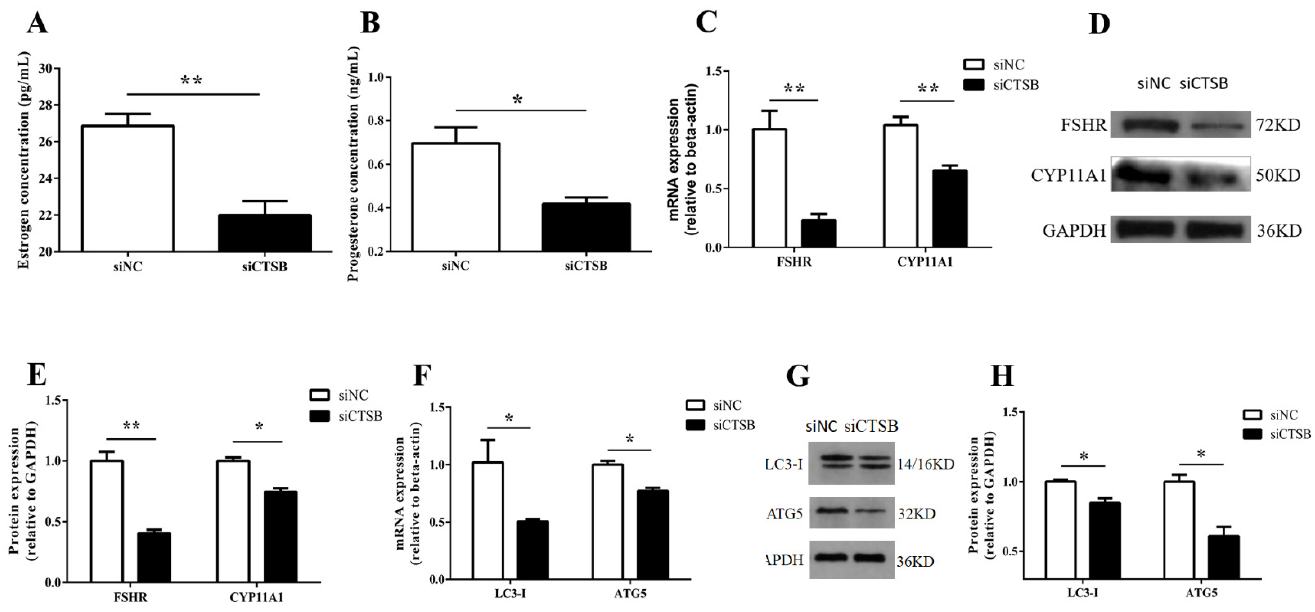
Figure 6. In vitro, CTSB deficiency altered the expression (mRNA and protein) of folliculogenesis and steroidogenesis marker genes in mouse GC. ( A , B ) At 48 h of GC transfection with siCTSB and NC, culture media was harvested, and estradiol and progesterone concentration was measured with an ELISA kit. ( C – E ) FSHR and CYP11A1 , as well as ( F – H ) LC3-I and ATG5 , were quantified at the mRNA and protein level through real-time PCR and Western blotting following siCTSB transfection. Results from three independent experiments were shown as means ± SEM. * p < 0.05, ** p < 0.01. siNC, negative control siRNA; siCTSB, cathepsin B siRNA; GCs, granulosa cells.